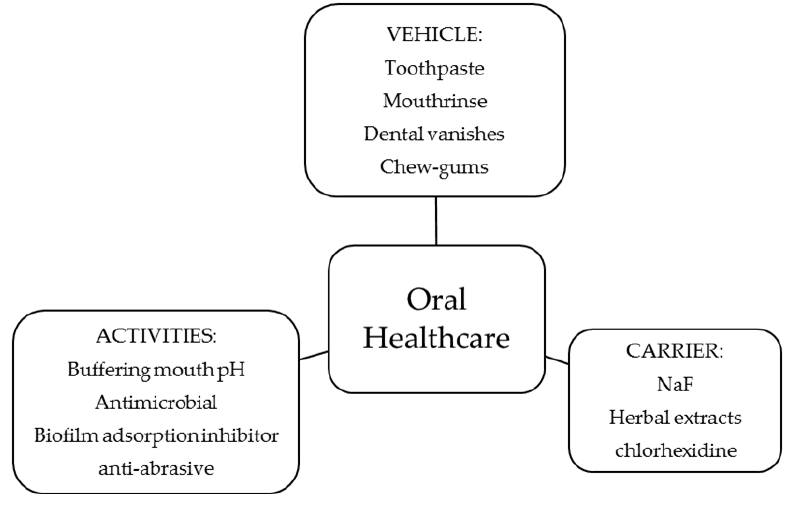
Figure 3. Use of chitosan and derivatives in preventive oral healthcare.